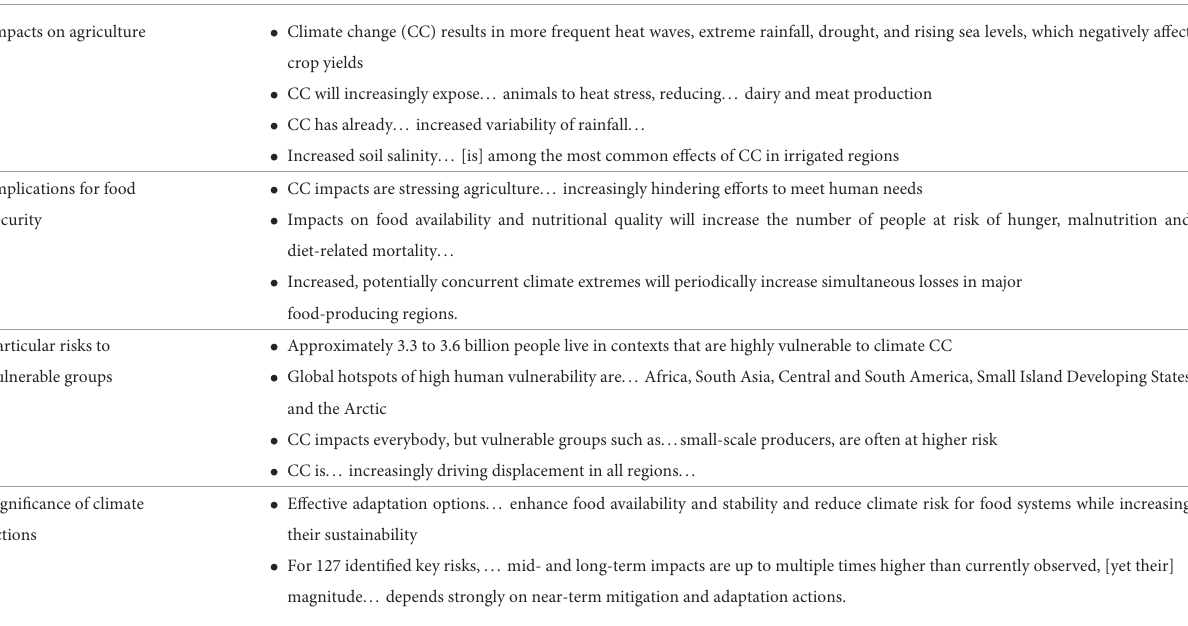
TABLE 1 Selected quotations from relevant sections of the latest IPCC report (IPCC, 2022a,b). Theme Selected